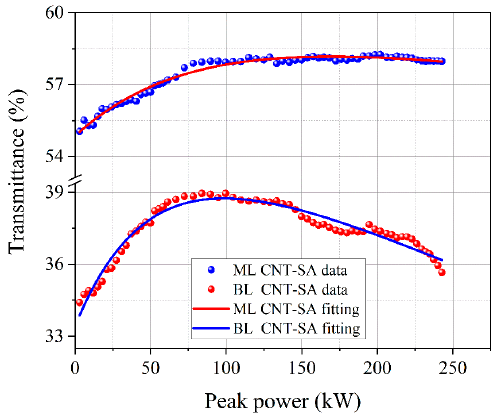
Figure 6. Nonlinear saturable absorption of ML CNT-SA and BL CNT-SA using homemade I-scan system.